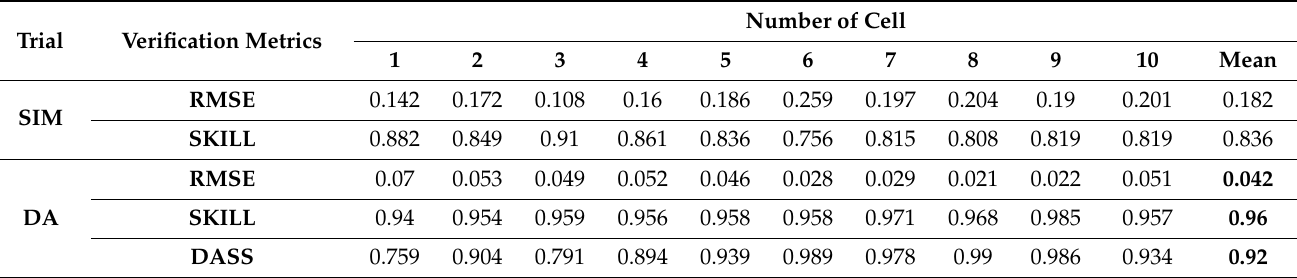
Figure 11. ( a ) Comparison of RMSE for the simulation and DA; ( b ) comparison of SKILL of the simulation and DA; ( c ) DASS of the experiment during the assimilation period. Table 4. RMSE, SKILL, and DASS of the simulations and DA in the assimilation time.